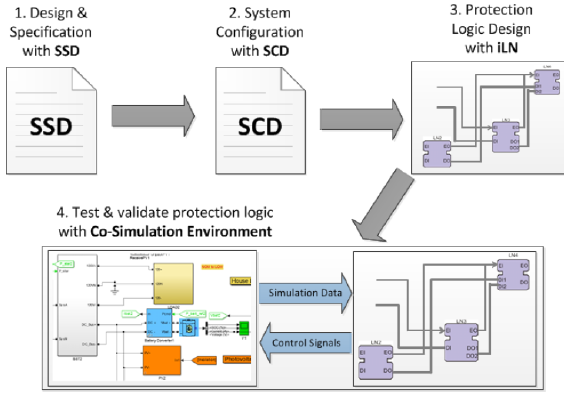
Figure 1. Design Process with SysGrid, from substation automation system specification to control